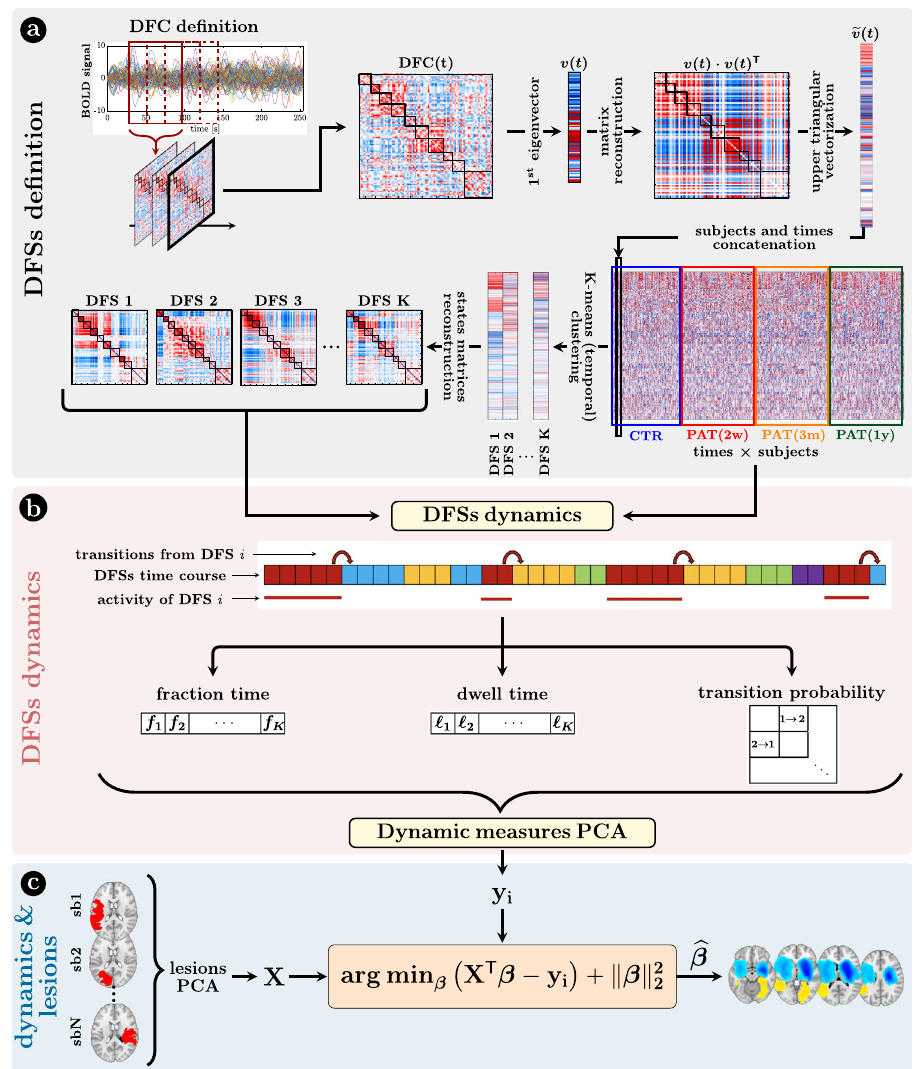
Fig. 1 | Methods (dynamical functional states). a De fi nition of the dynamic functional states (DFSs): (i) at fi rst, the time course of each subject was divided into 270 time-windows of width=30 TR (600s) and step=1 TR. The z-Fisher transform of the Pearson ’ s correlation coef fi cient among regions was computed ateachslidingwindow,toestimatetheDynamicalFunctionalConnectivity(DFC). Then, (ii) each DFC matrix was approximated by projecting on the leading eigenspacede fi nedbythe fi rsteigenvector v i .Astheeigenvectorsarede fi nedless than the sign, we avoided this issue by reconstructing the square matrix v i × v T i . After that, (iii) the upper triangular part of these rank-one DFC matrices was vectorized and concatenated across windows and subjects, in order to fi nally apply a time-wise K-means clustering algorithm with correlation distance and 20 replicates (iv) to de fi ne a set of K spatial DFSs. Silhouette and Davies-Bouldin algorithms were used to search for the optimal number of DFSs. Several SC2 (limbic)correlates positively with the DMN in DFS1, but negatively in DFS3. Correspondingly, SC2 shows no correlation with sensory- motornetworks in DFS1, but apositive correlation in DFS3. In contrast, SC1 (nuclei) shows no correlation with DMN in DFS1, but a positive